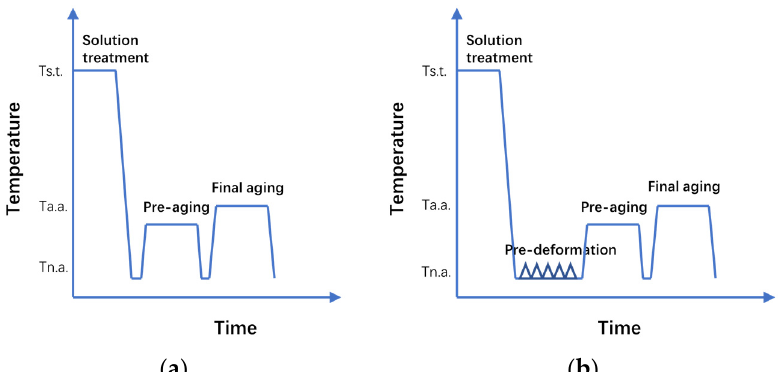
Figure 1. The schematic illustrations of processing routes for the Al-Mg-Zn-Cu alloy after cold rolling: ( a ) T6 route; ( b ) FTMT route.